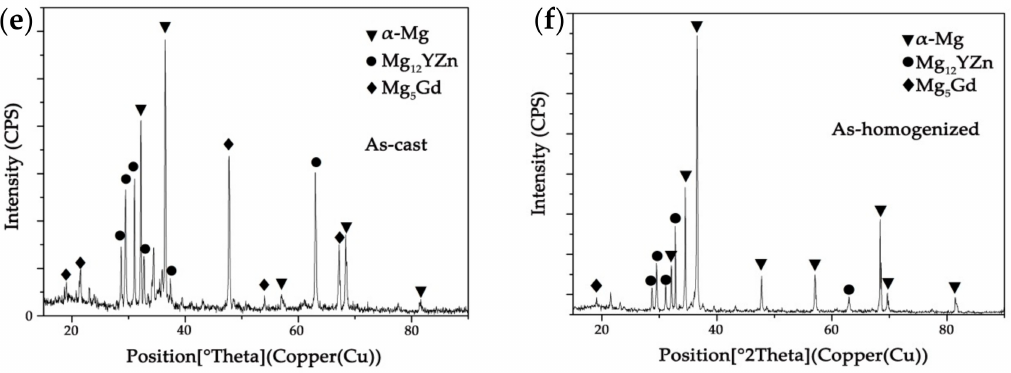
Figure 3. Microstructure observation of ( a , c ) as-cast alloy, ( b , d ) homogenized alloy and XRD patterns of Mg alloy before ( e ) and after ( f )